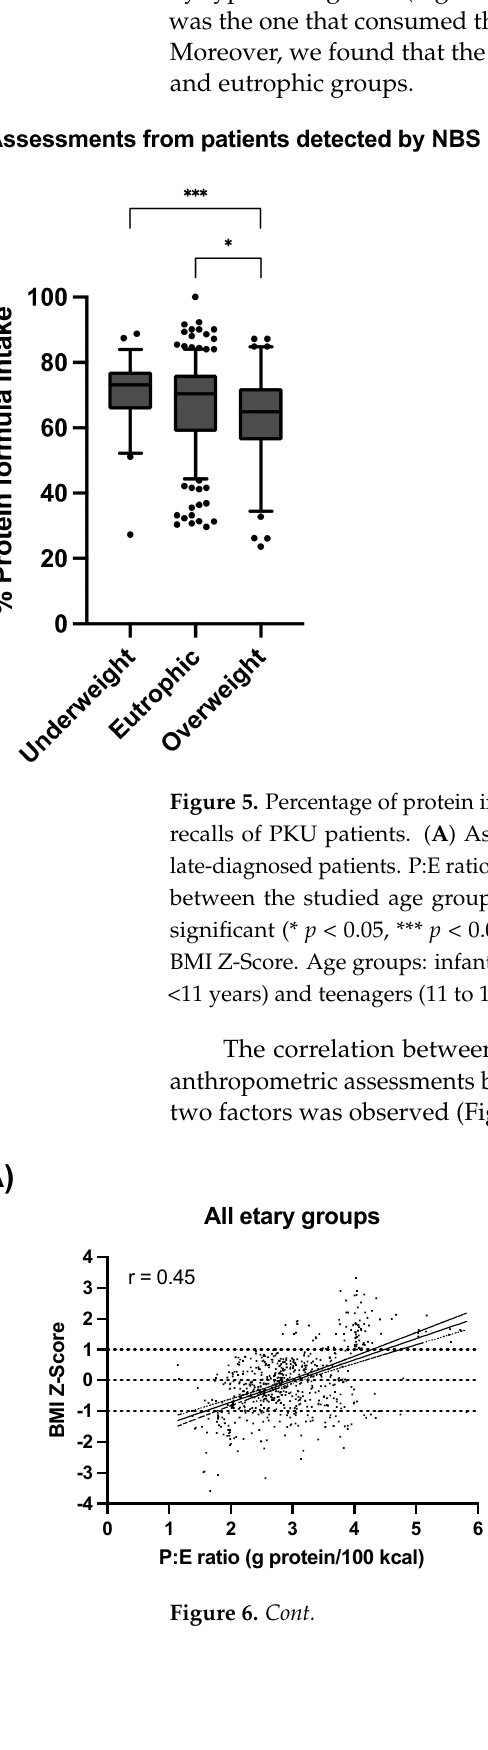
Figure 6. Pearson’s correlation between P:E ratio and BMI Z-Score in PKU patients classified by age group. P:E ratio was calculated from patients’ dietary recalls and is expressed as protein per 100 kcal. BMI Z-Score was calculated from anthropometric measurements (weight, height). Eutrophic